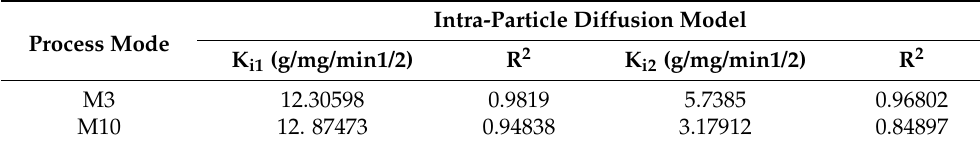
Table 7. Fitting constant values of the intra-particle diffusion